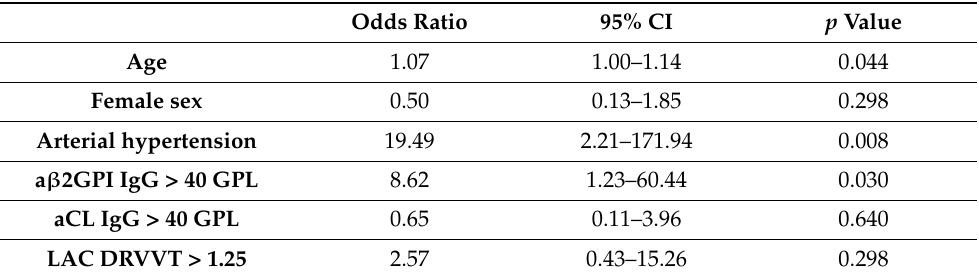
Table 4. Multivariate logistic regression analysis of factors associated with heart failure with pre- served ejection